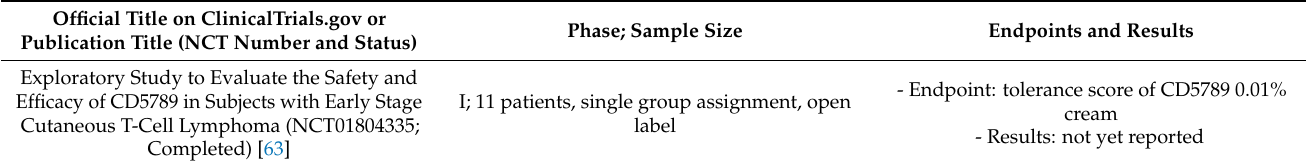
Phase; Sample Size